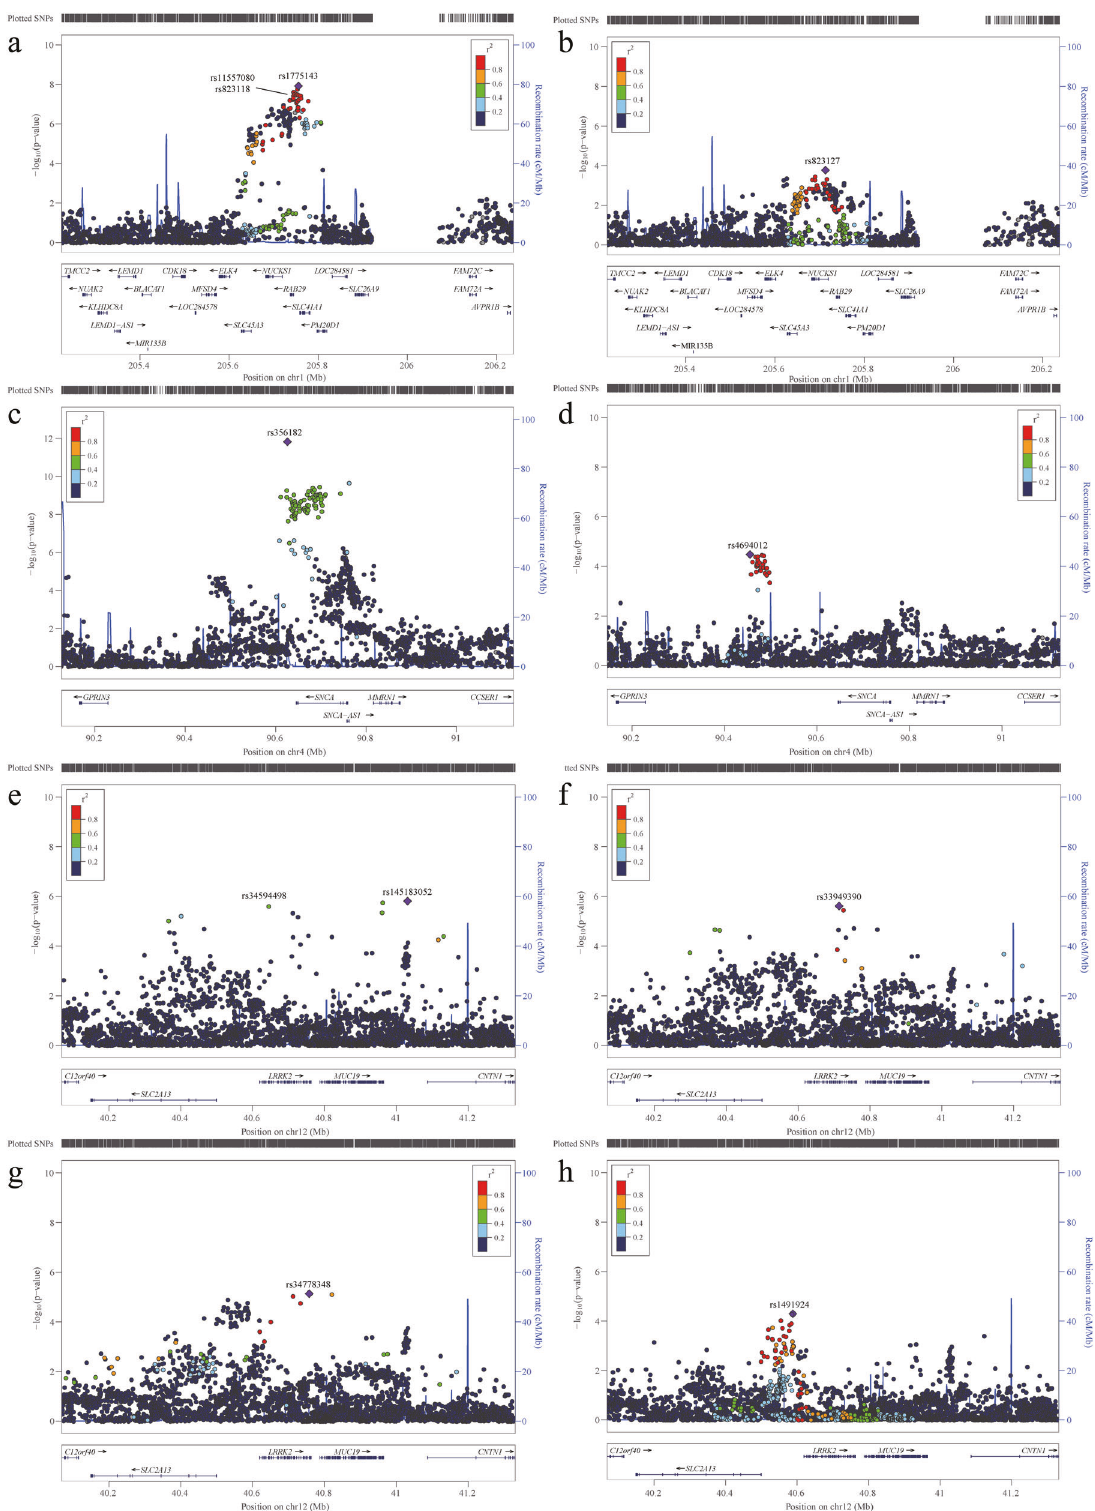
Fig. 3 Regional plot of conditional analysis of reported loci with multiple independent signals. a , b Conditional analysis in NUCKS1/RAB29 region. c , d Conditional analysis in SNCA region. e – h Conditional analysis in LRRK2 region. Reference data of Asian population from 1000 Genomes were used for linkage disequilibrium